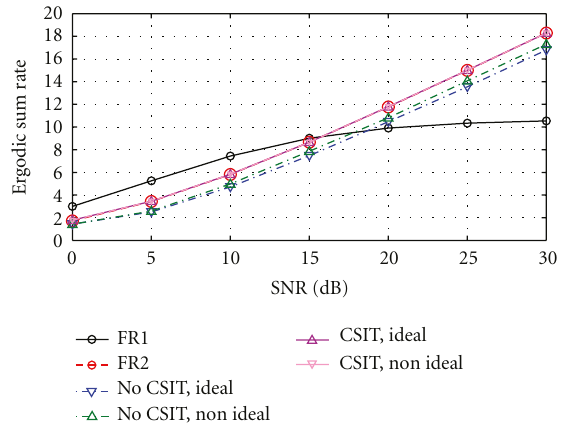
Figure 7: Average sum rate of M 0 and M 1 , as a function of the SNR (dB), for two isolated base stations.The link quality is α = 0 . 25. The non ideal link denotes the case when the base station-to-base station link gain is β = α .